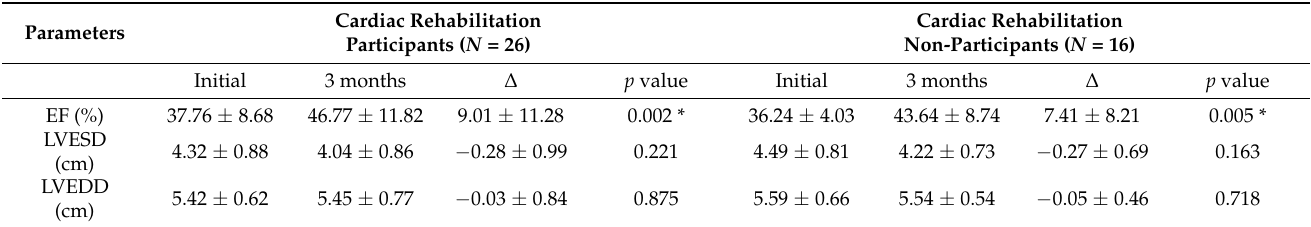
Table 4. Changes of echocardiographic parameters between cardiac rehabilitation participants and